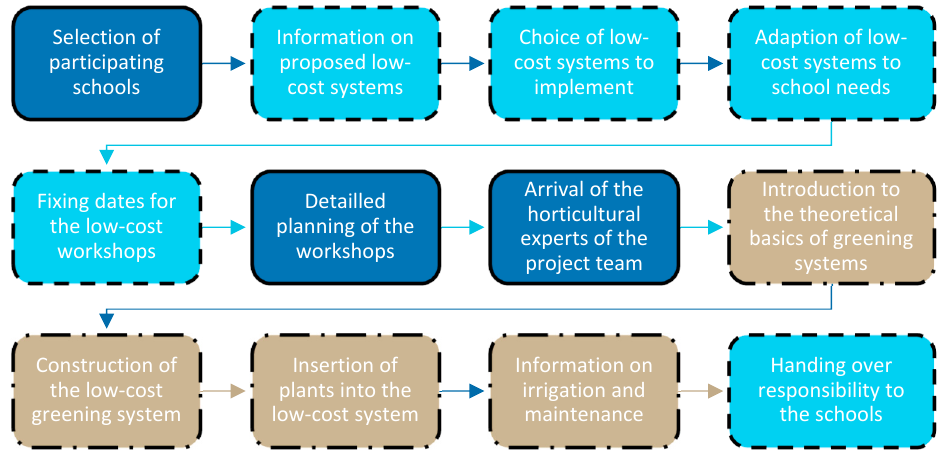
Figure 8. Realization of the low-cost workshops in the federal states; dark blue, framed throughout: work in the project team; light blue, dashed framed: integration of the school authorities; beige, dash dot framed: integration of the students of the selected school classes throughout Austria.